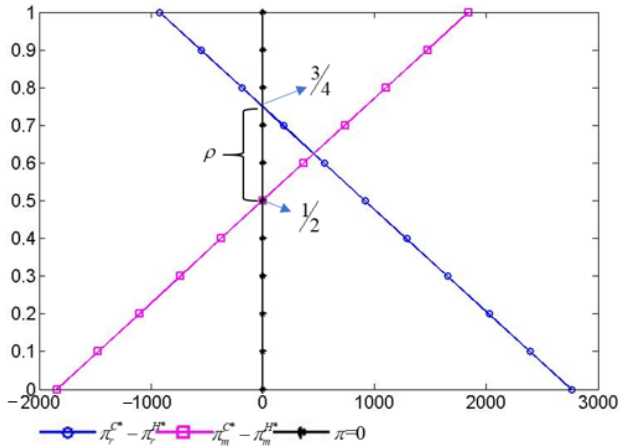
Figure 9. Coordination conditions after adopting a blockchain-based ACTS.